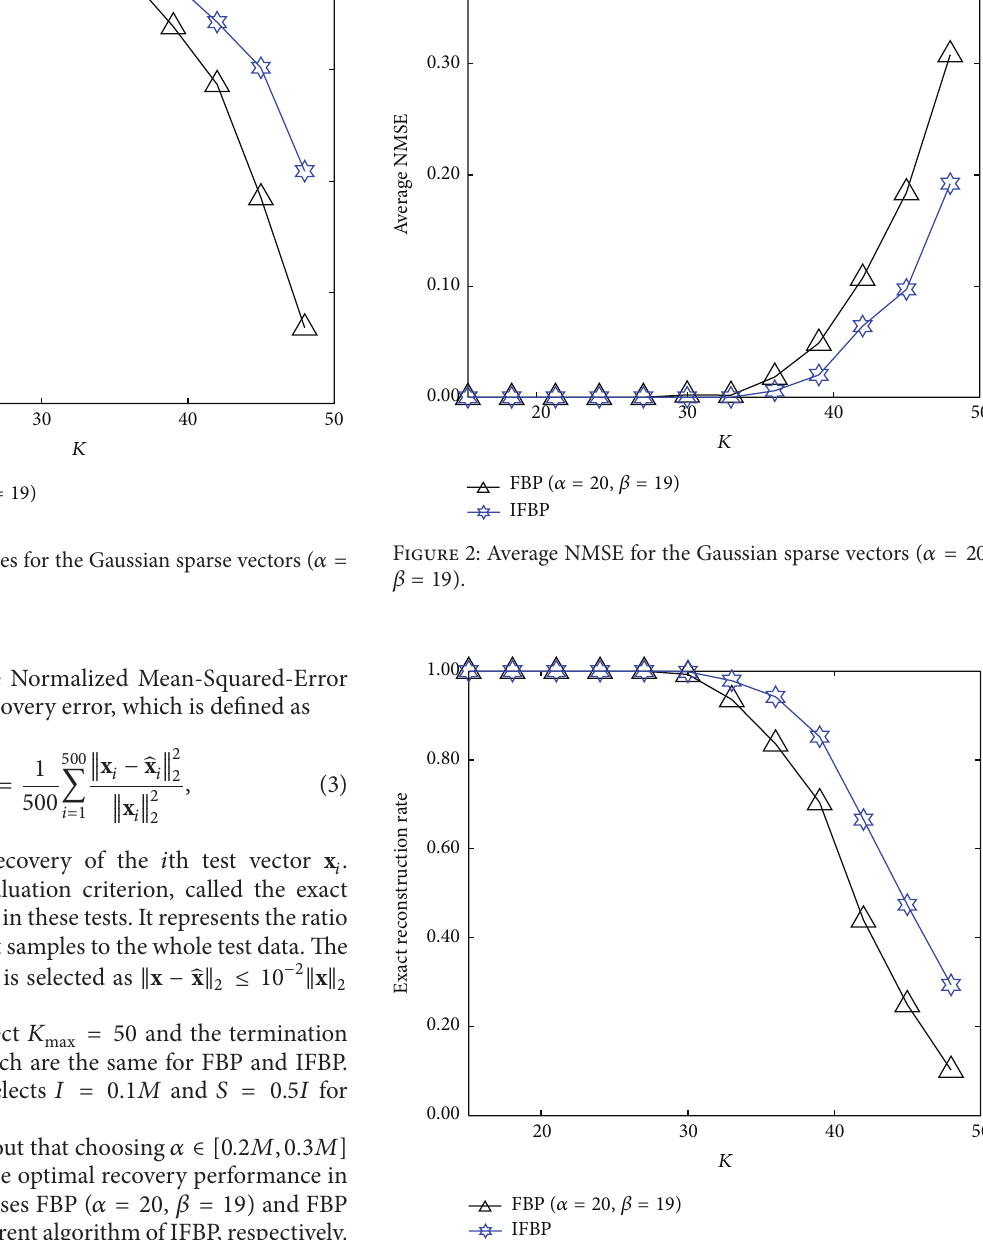
Figure 3: Exact recovery rates for the uniform sparse vectors ( 𝛼 = 20 , 𝛽 = 19